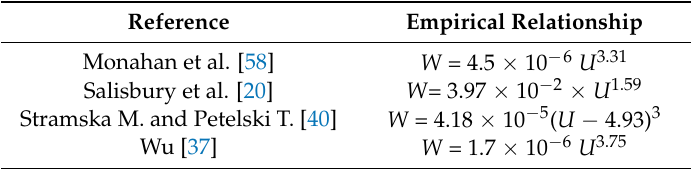
Table 7. Wind speed empirical